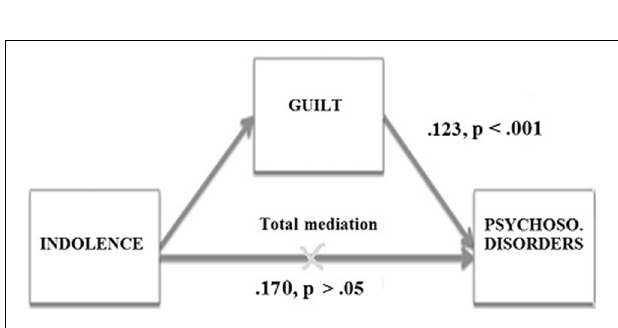
FIGURE 5 | Mediation of the variable Guilt in the relationship between the SQT and Psychosomatic disorders in the Portuguese